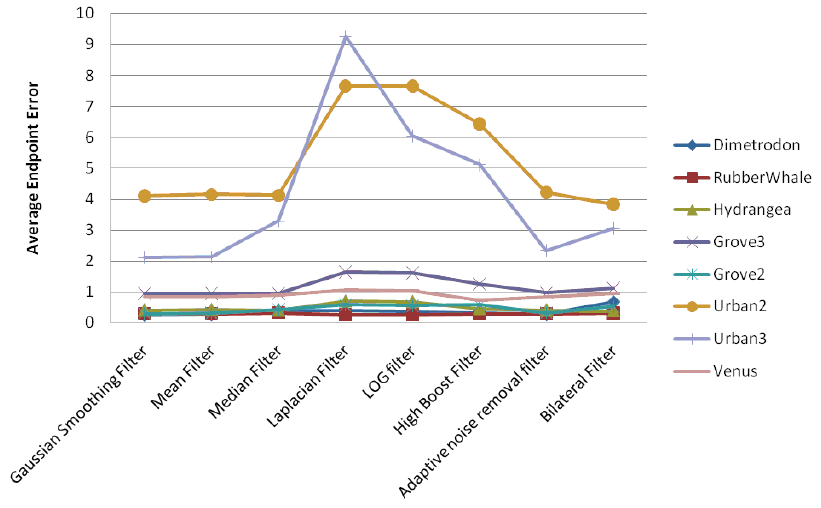
Figure 5. Average angular errors using different filters only on input